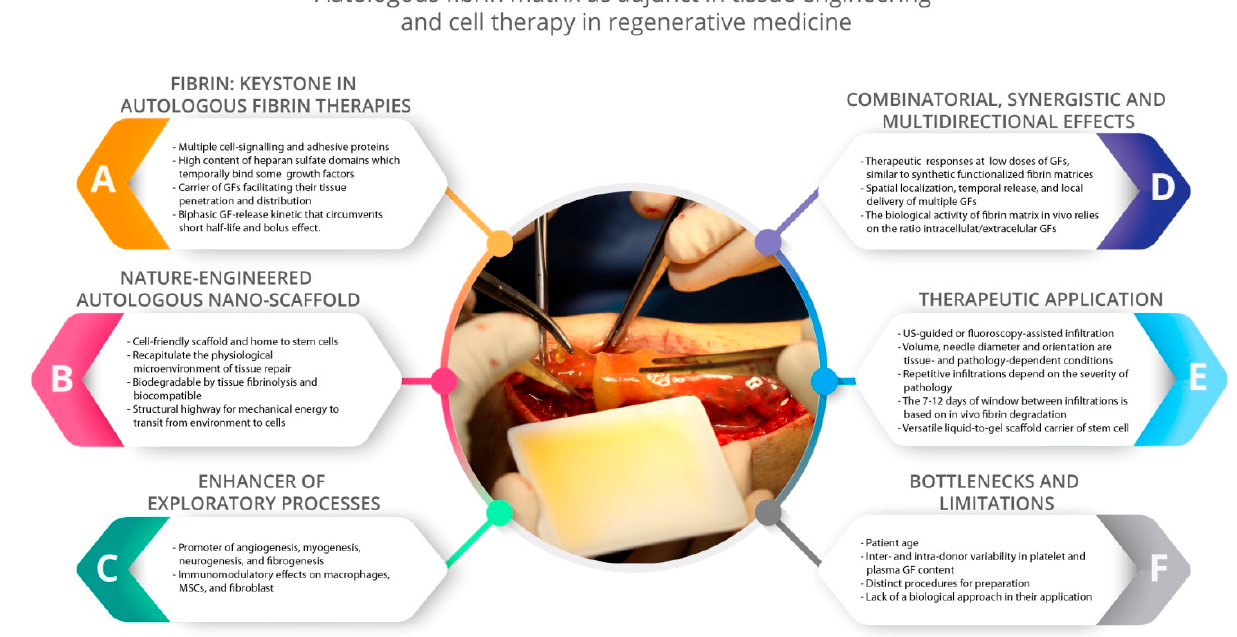
Figure 2. Summary of the primary biological and therapeutic features of platelet-rich plasma (PRP). PRP has emerged as an adjuvant human blood-derived constructs to assist tissue engineering and cell therapies in regenerative medicine. Figure adapted from [17] with permission.